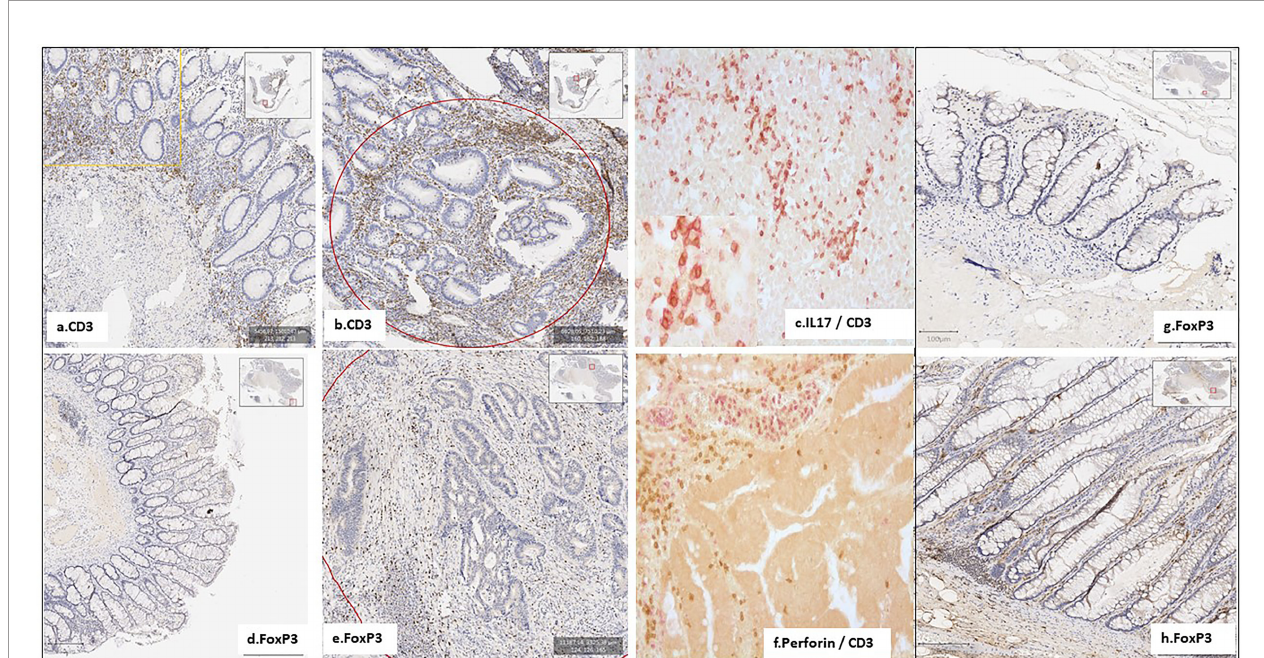
FIGURE 3 | Few in fl ammatory and immune cells were detected in the homologous normal colonic mucosa, compared to the tumoral tissue, in the patient with CRC (FR.901) (A – F) . No active immune cells were detected in her monozygotic twin sister ’ s polyps (FR.902P20) (G, H) . Notably, the IL17 TH pathway is involved in CD4+ Foxp3+ IL-17+ cells, which were expanded in both CRC and adenomatous patients, with a trend towards elevated immunostained cells in CRC